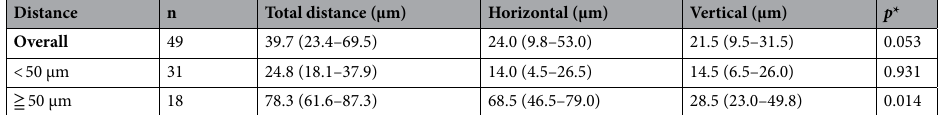
Table 3. Total distance between the center of the FAZ and the highest point of the foveal bulge. Data are presented as numbers or median (interquartile range). * p values were calculated by comparing the absolute values of horizontal and vertical distances using the Wilcoxon signed-rank